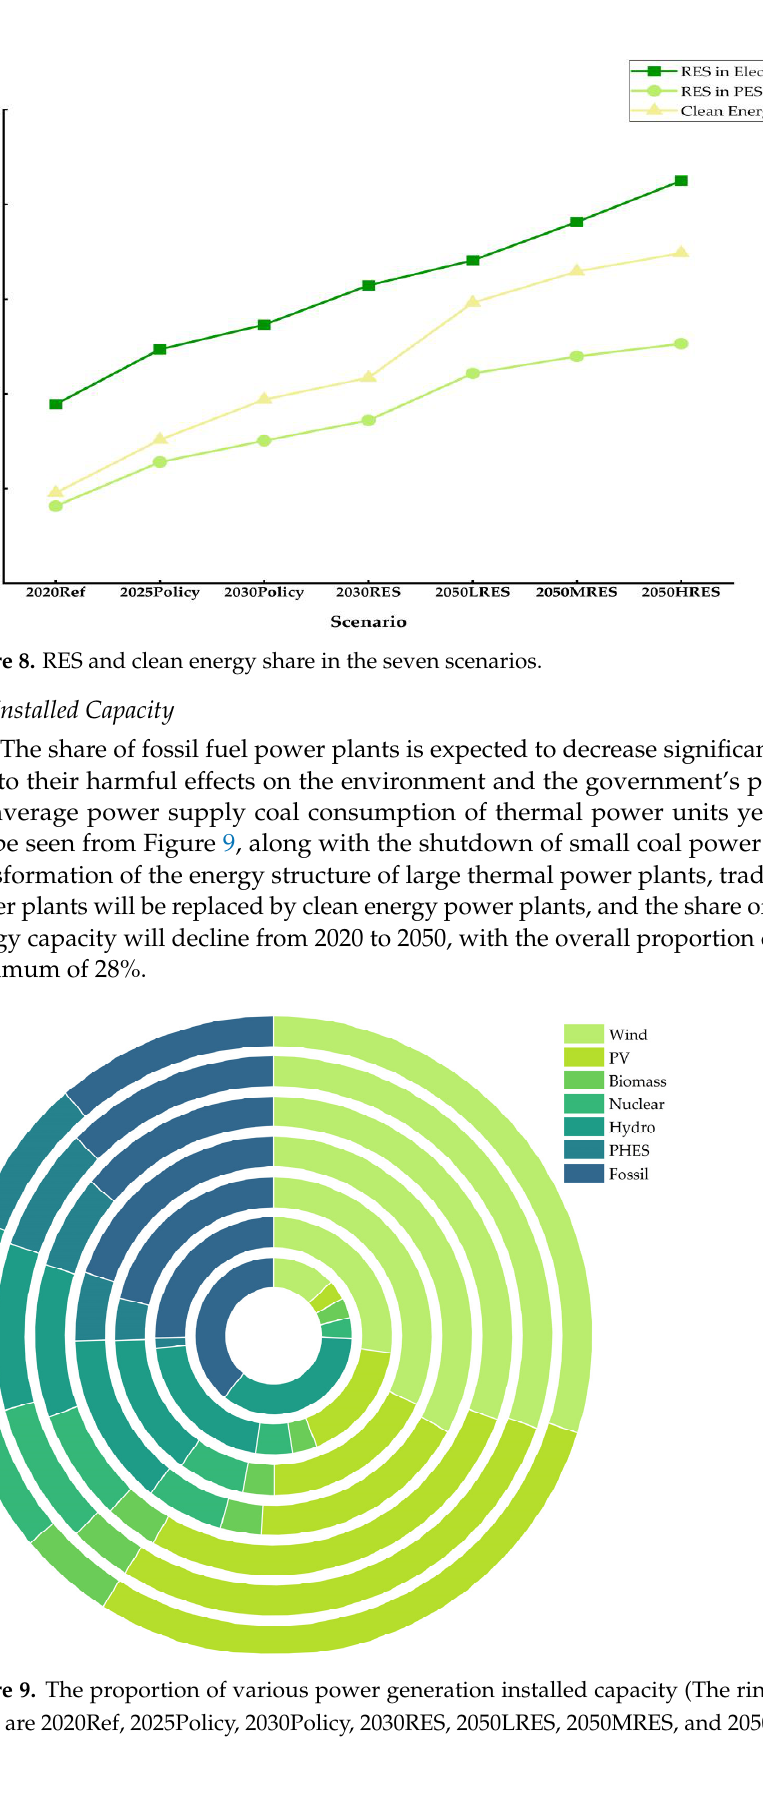
Figure 7. Total primary energy consumption and their carbon emissions.